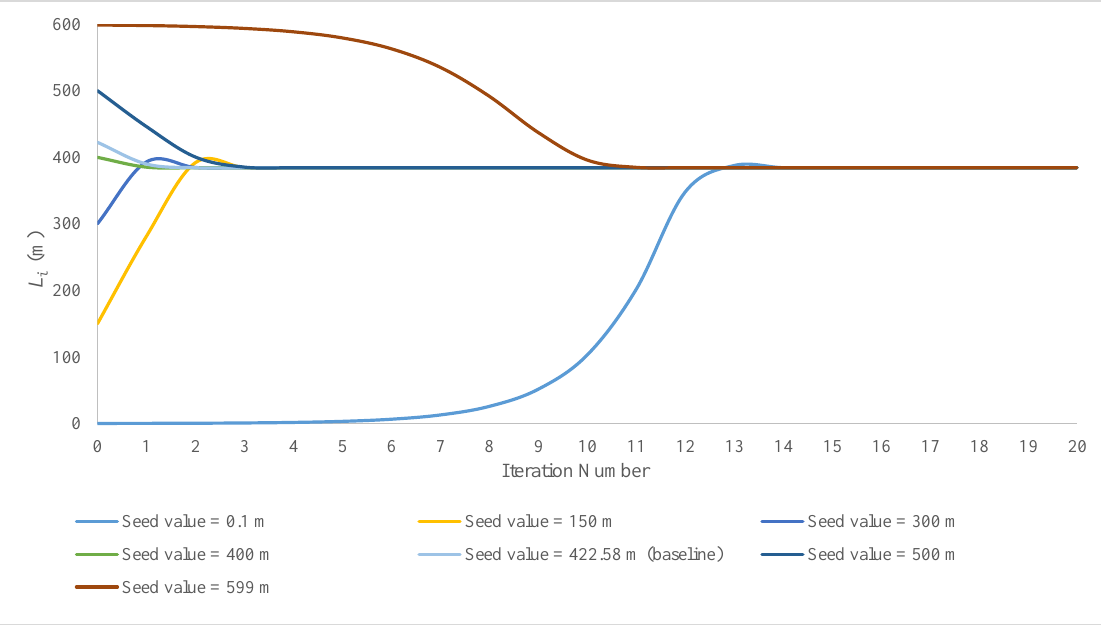
Figure 5. Sensitivity analysis of seed values.